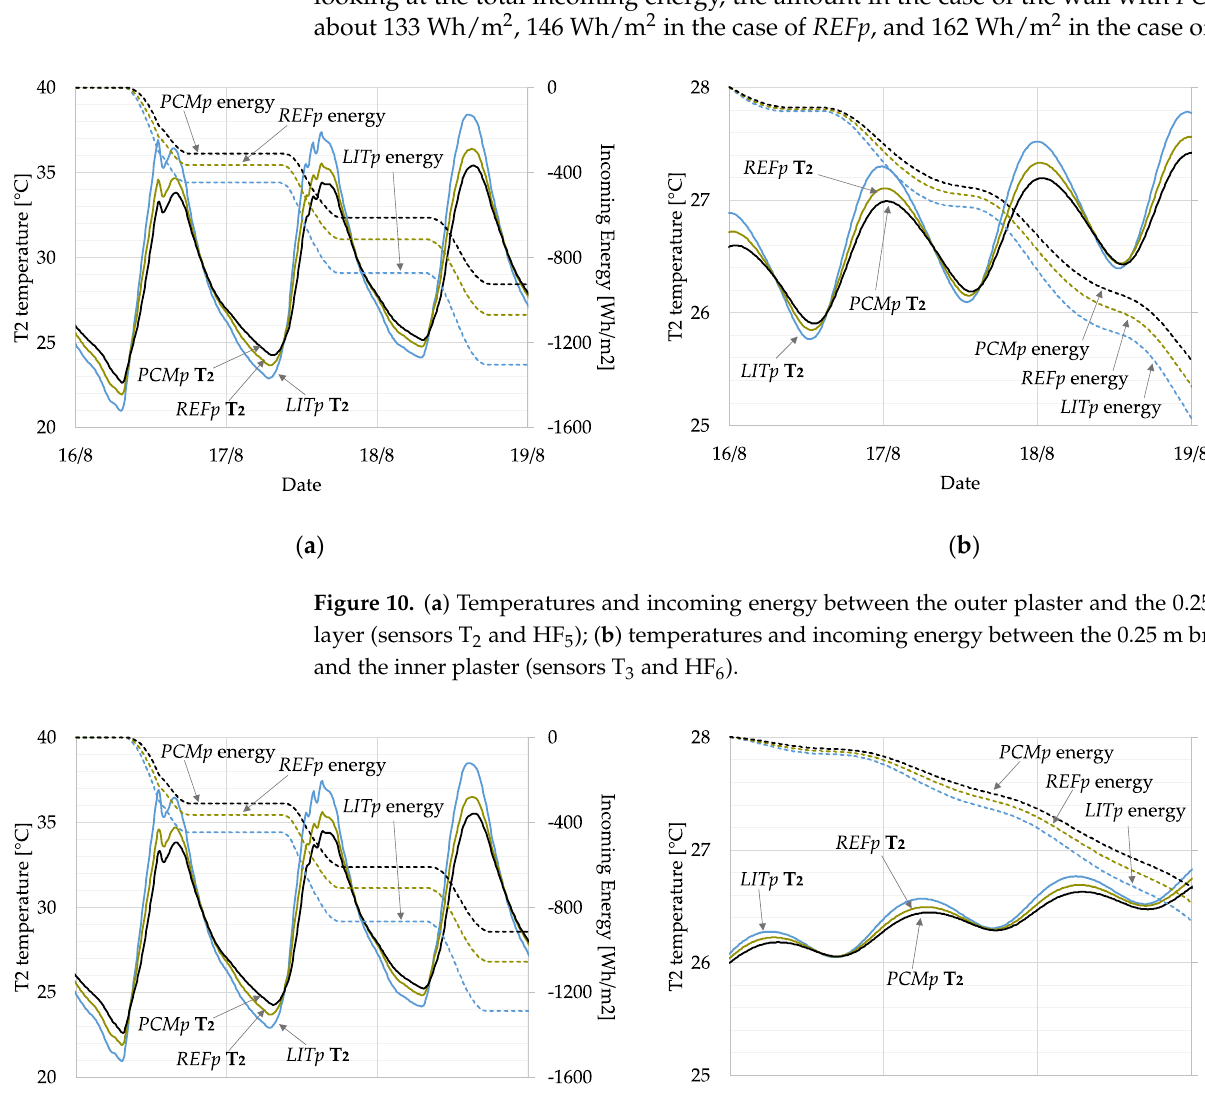
Figure 10. ( a ) Temperatures and incoming energy between the outer plaster and the 0.25 m brick layer (sensors T 2 and HF 5 ); ( b ) temperatures and incoming energy between the 0.25 m brick layer and the inner plaster (sensors T 3 and HF 6 ).